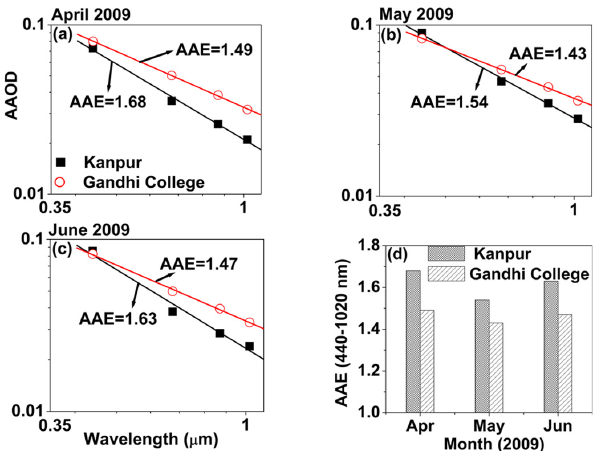
Fig. 7. The absorption aerosol optical depth (AAOD) versus wave- length for Kanpur and Gandhi College during (a) April 2009, (b) May 2009 and (c) June 2009. The curve fit straight line rep- resents the best-fit absorption Angstrom exponent (AAE) shown by arrows. (d) AAE for the wavelength region of 440–1020nm at Kan- pur and Gandhi College during April to June